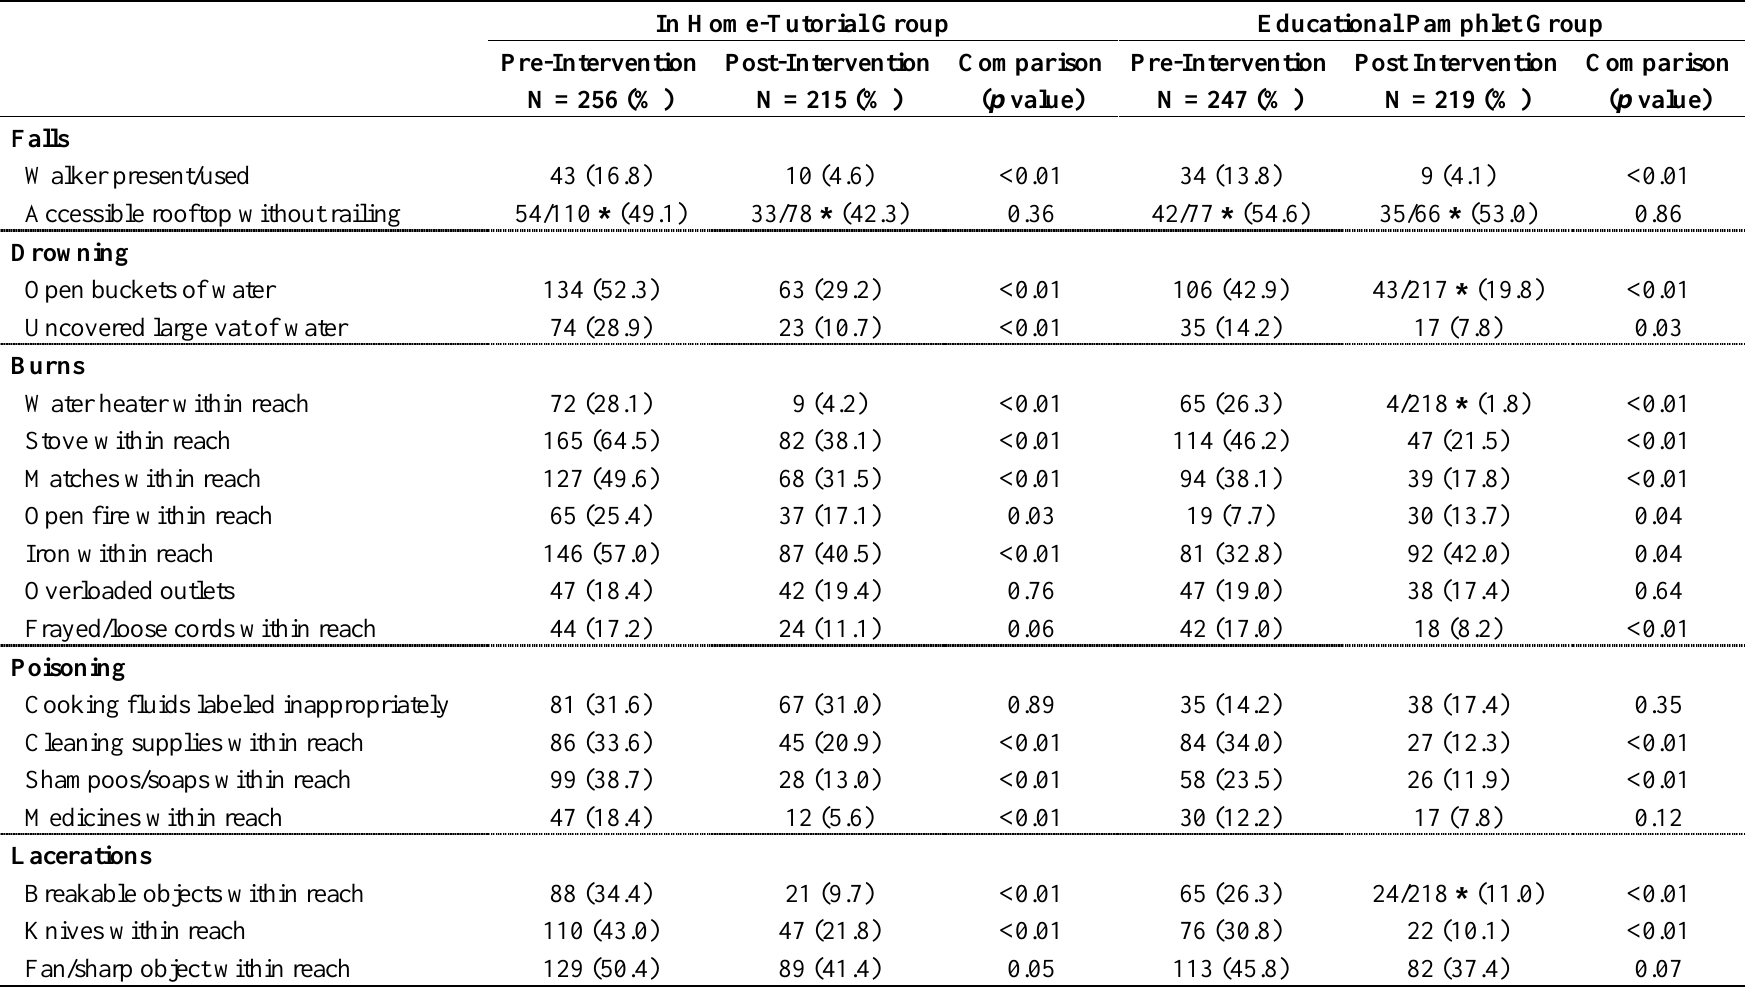
Table 2. Comparison of presence of hazard pre and post intervention by